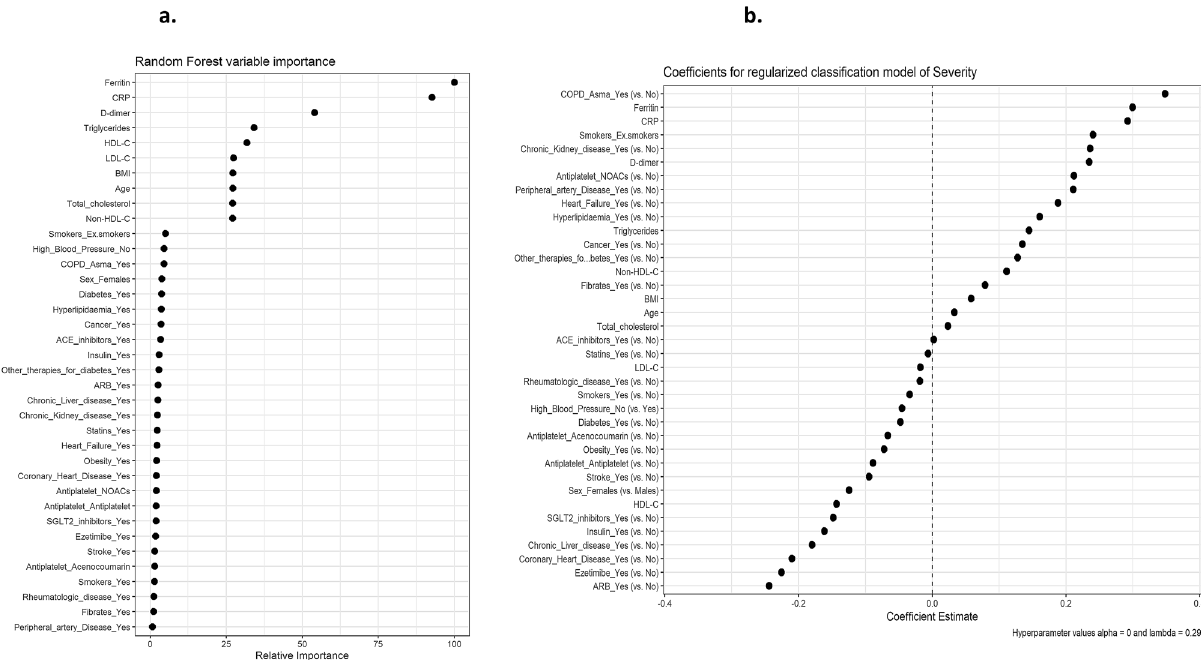
Figure 5. ( a ) Plot depicting the out of bag importance of each analysed variable on COVID-19 random forest model. P values of the variables of interest according a variable permutation analysis: Ferritin: 0.017; CRP: 0.009; D-Dimer: < 0.001; triglycerides: 0.006; HDL-C: 0.019; LDL-C: 0.026; Body mass index: 0.008; age: < 0.001; total cholesterol: < 0.001; non-HDL-C: < 0.001. ( b ) Coefficients for regularized classification model of severity applicable to ( a ) data indicating the direction of the